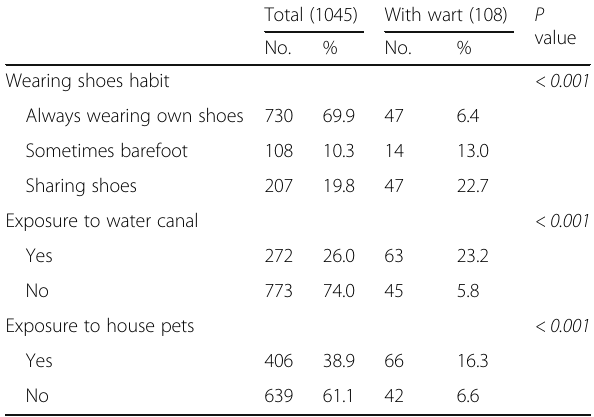
Table 4 Logistic regression of factors associated with wart infection among primary school students, academic year 2015 – 2016, Tema District, Sohag,